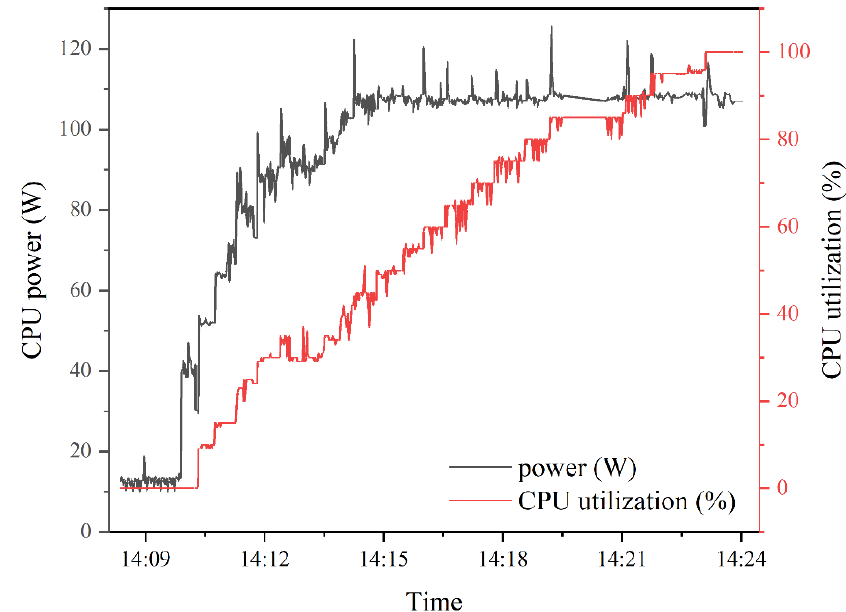
Figure 3. Power variation process under different CPU loads.